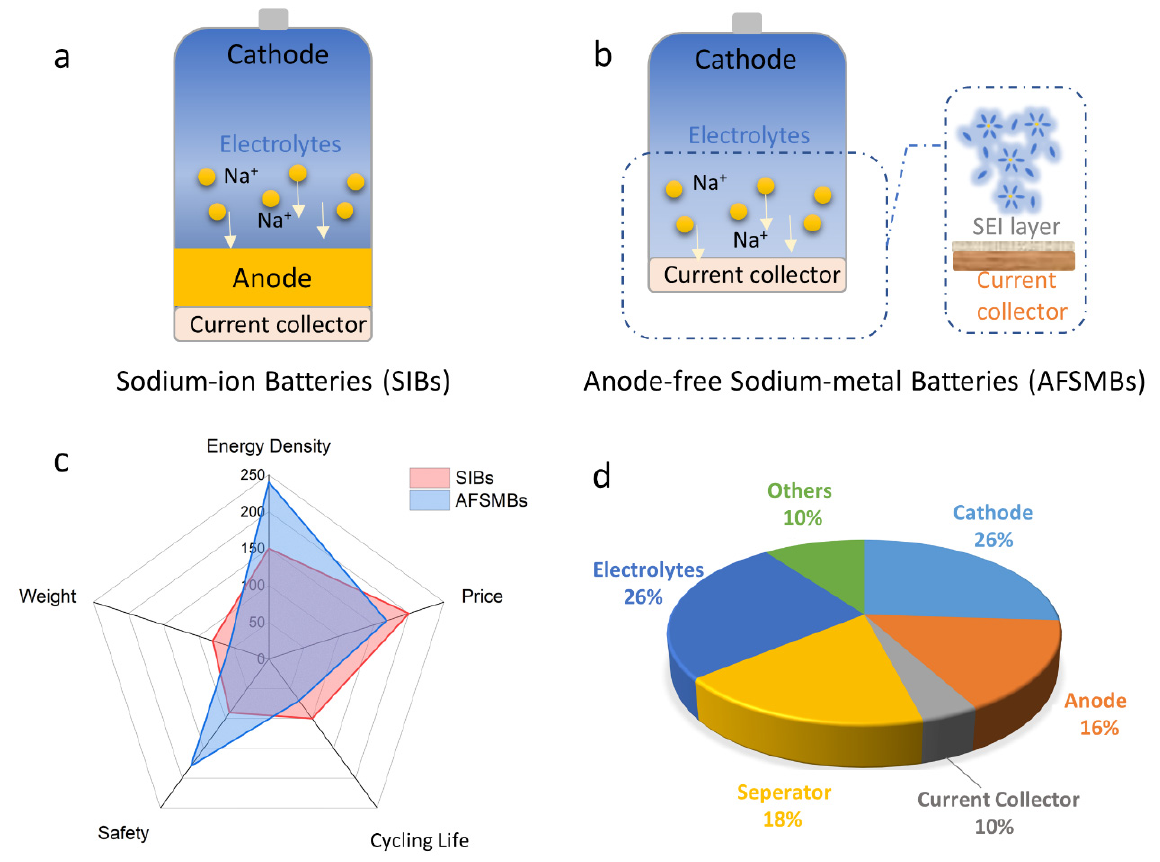
Figure 1. Schematic diagram of the structure of the two batteries: ( a ) Traditional sodium–ion batteries; ( b ) Anode–free Sodium-metal Batteries (AFSMBs); ( c ) Multi–angle comparison of the SIBs and AFSMBs with crucial indicators of energy density, weight, safety, cycling life, and price; ( d ) Percentages of the cost of each component in SIBs, which indicates that the 16% from the anode parts can be saved in AFSMBs.